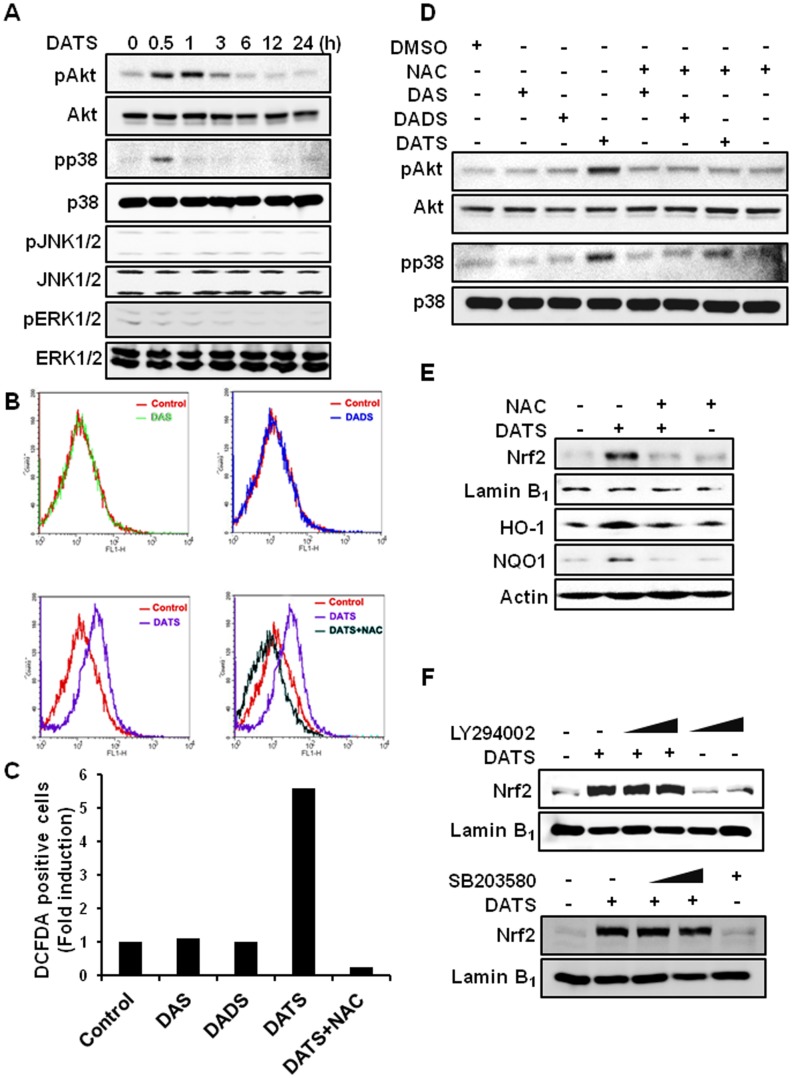
ROS, but not Akt or p38 MAPK, are involved in DATS-induced Nrf2 activation.(A) AGS cells were incubated with DATS (20 µM) for the indicated time, and the expression of both phosphorylated and total forms of Akt, p38 MAPK, JNK1/2, and ERK1/2 were measured by Western blot analysis. (B) AGS cells were incubated with 20 µM of DAS, DADS, and DATS in the presence of NAC (1 mM) for 3 h. ROS accumulation was determined by the DCF-DA assay as described in Metarials and Methods. (C) Data are represented as fold induction of the number of DCF-DA positive cells (n = 5) calculated from Fig. 4B. (D) AGS cells treated with DAS, DADS, or DATS (20 µM, each) for 0.5 h with or without NAC (1 mM) were analyzed by Western blotting to detect phosphorylated and total Akt and p38 MAPK. (E) Cells treated with DATS (20 µM) in the absence or the presence of NAC (1 mM) were harvested to determine the nuclear level of Nrf2 and the protein expression of HO-1 and NQO1. (F) AGS cells were pre-treated with 12.5 and 25 µM of LY 294002, an inhibitor of PI3K/Akt, or SB203580, a pharmacological inhibitor of p38 MAPK, followed by DATS (20 µM) treatment for 1 h. The nuclear protein extract was subjected to immunoblot analysis for the detection of Nrf2 expression.